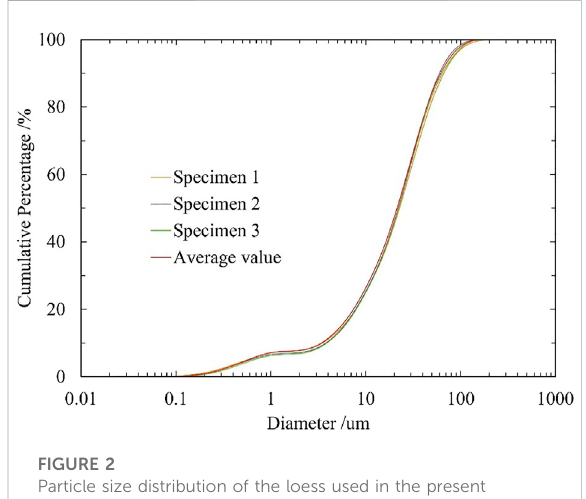
Particle size distribution of the loess used in the present study.